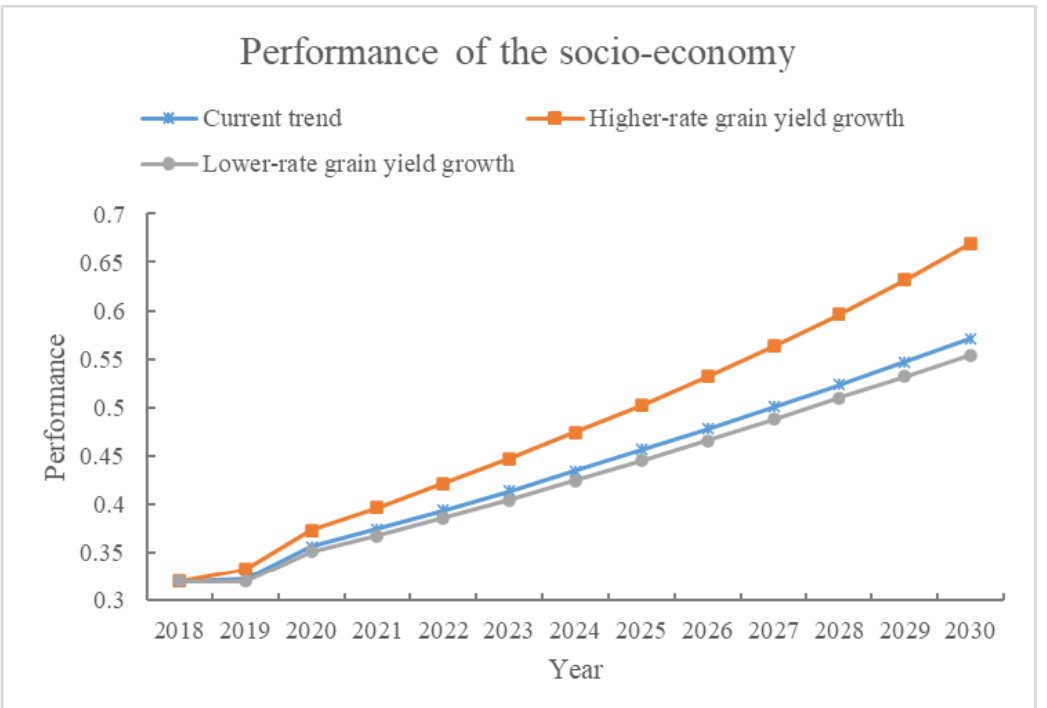
Figure 6. Performance of the socio-economy under three scenarios.